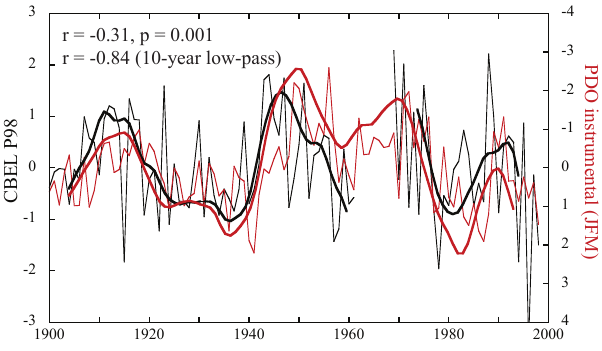
Figure 3. Instrumental PDO (NOAA) compared with grain size at Cape Bounty East Lake from 1900 to 2000 (best correlation is achieved when CBEL lags PDO by 1 year). Bold lines are 10-year low-pass filtered. A turbidite dated to 1971CE eroded 7 years (La- pointe et al.,